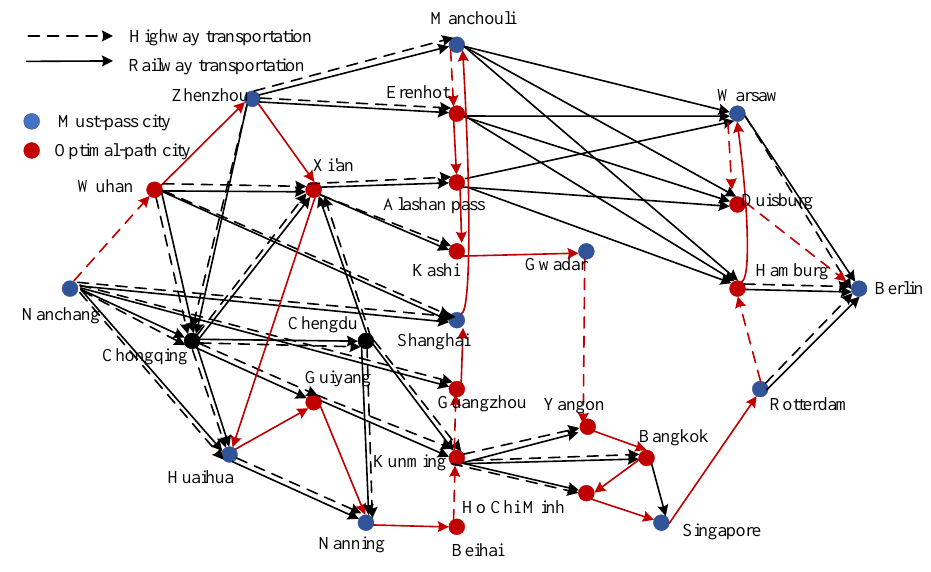
Figure 11. Optimization of Nanchang–Berlin multimodal transport network by AGA algorithm.